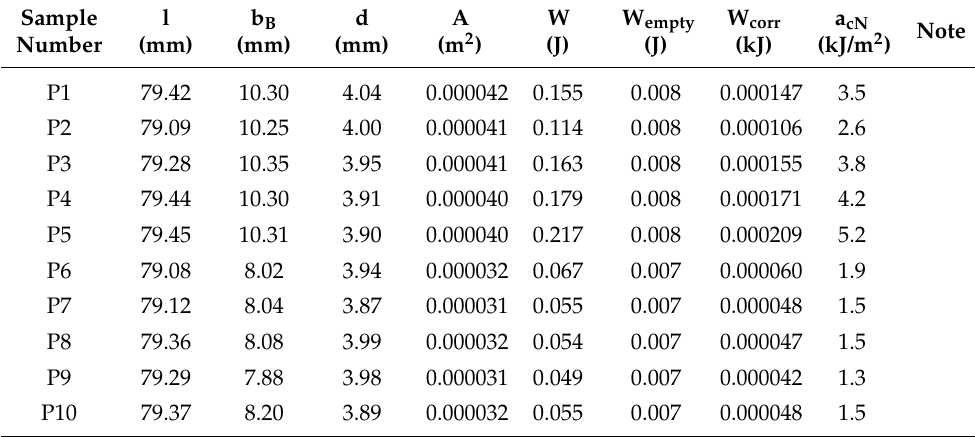
Table A17. Results of the notched impact tests and unnotched impact tests of P_W,C,PS.